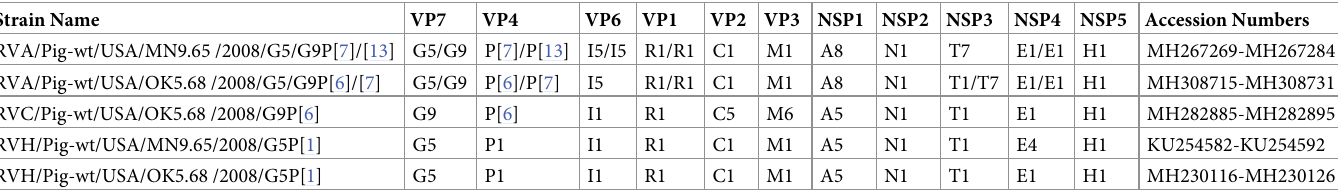
Table 1. Genome constellation and GenBank accession number for each RV